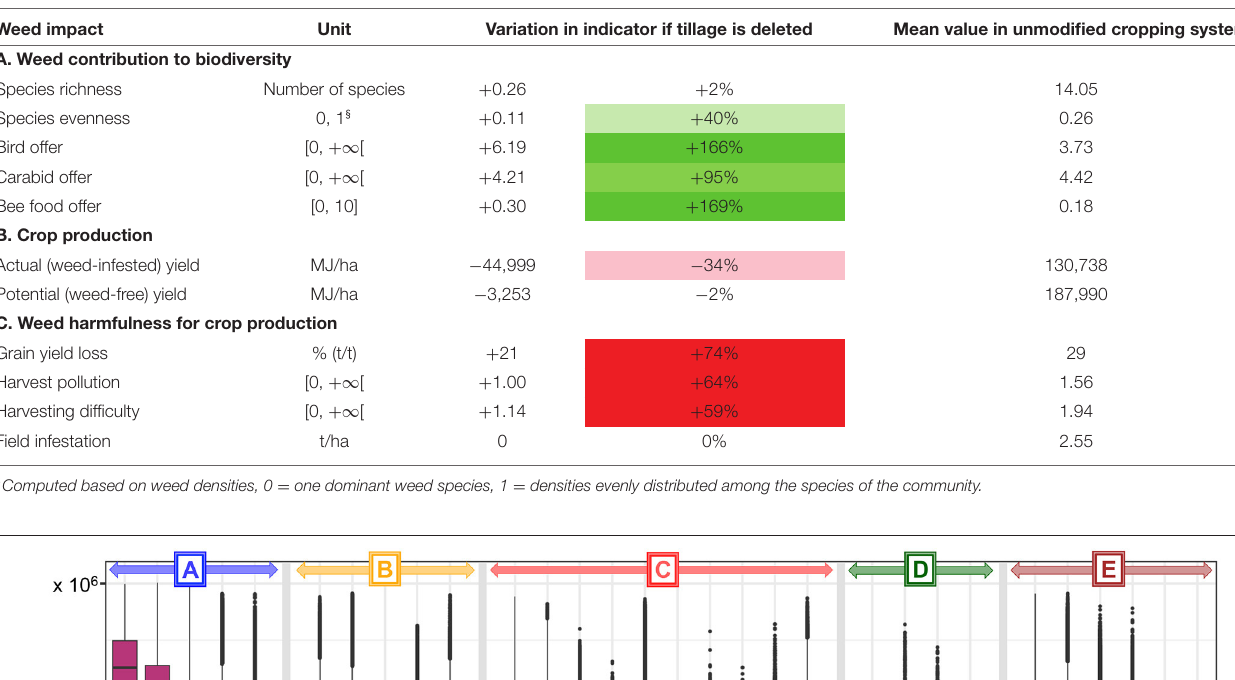
TABLE 3 | Which weed impacts were impacted most when tillage was deleted without any other changes in management practices? Average difference in weed impact indicators from tillage-free simulations—values from unmodified cropping systems (395 systems × 30 years × 10 weather repetitions) (percentages show variation relatively to mean indicator values from unmodified cropping systems). Cells of relative variation were colored in green for beneficial effects (increased biodiversity) and red for detrimental effects (decreased yield, increased weed harmfulness), and the stronger the relative variation was, the darker the color.